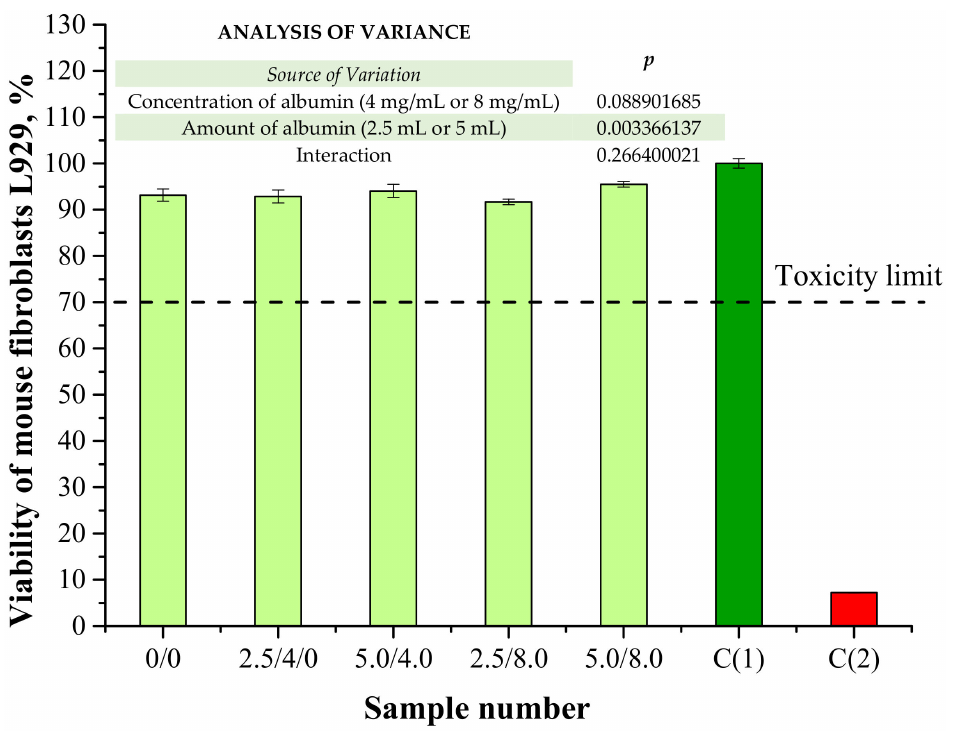
Figure 16. Results of cytotoxicity evaluation via MTT reduction assay (n—number of repe- titions, n = 3; p indicates the statistical significance calculated using the two-way analysis of variance